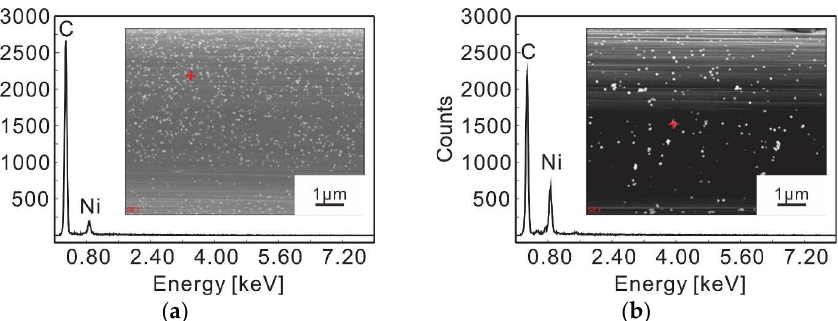
Figure 3. Elemental analyses of ( a ) D-Ni-CF ( I = 200 mA, J = 3.79 A/m 2 , t = 5 s) and ( b ) P-Ni-CF ( I = 200 mA, J = 3.79 A/m 2 , t ON = 10 ms, t OFF = 100 ms, t = 5 s) performed by EDS.